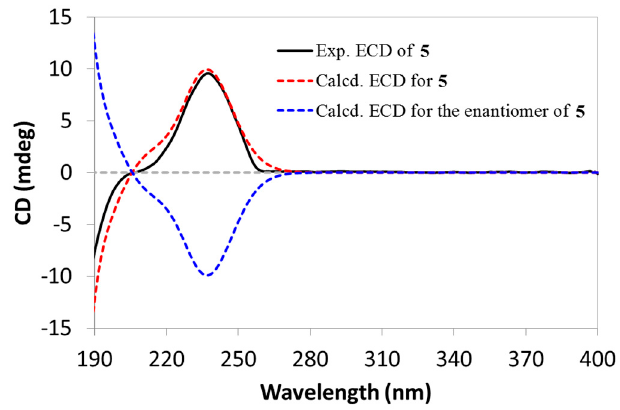
Figure 5. Experimental ECD spectrum Compound 5 (black) compared with the calculated ECD spectra of Compound 5 (red) and its enantiomer (blue).